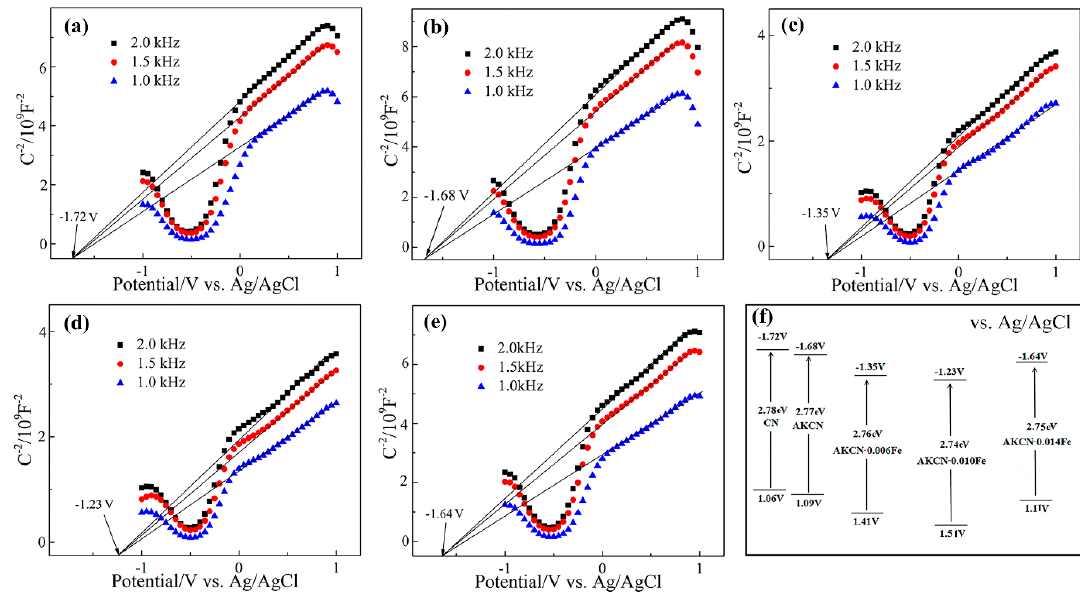
Figure 6. Electrochemical Mott–Schottky plots of ( a ) CN, ( b ) AKCN, ( c ) AKCN-0.006Fe, ( d ) AKCN-0.010Fe, and ( e ) AKCN-0.014Fe; ( f ) electronic band structures of different samples.